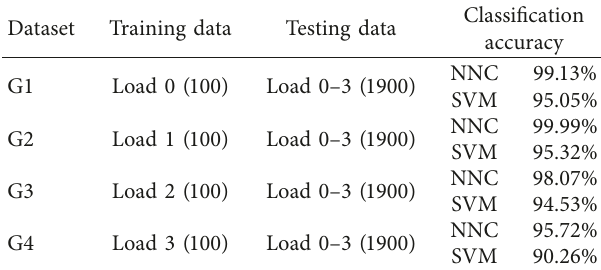
Table 11: Performance comparison between NNC and SVM under limited training sample